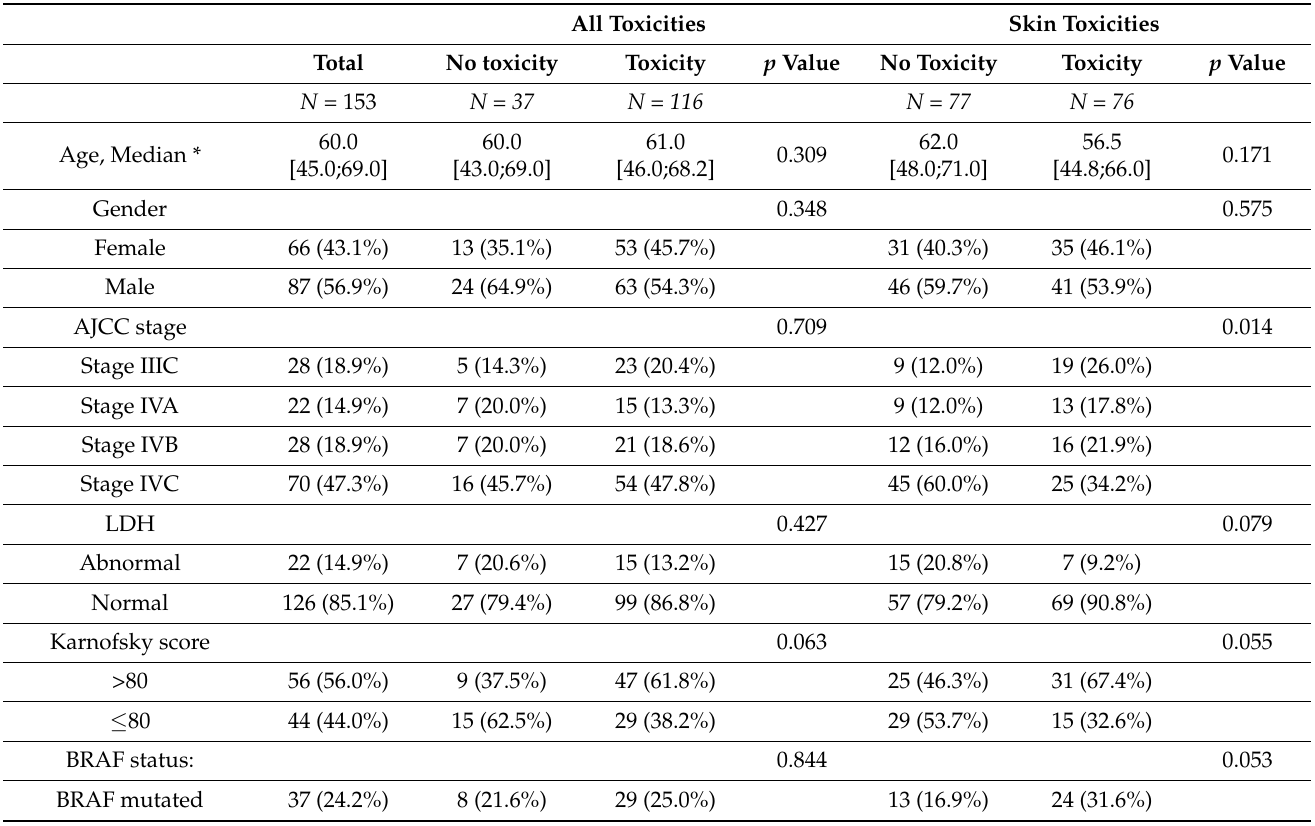
Table 1. Baseline characteristics of the